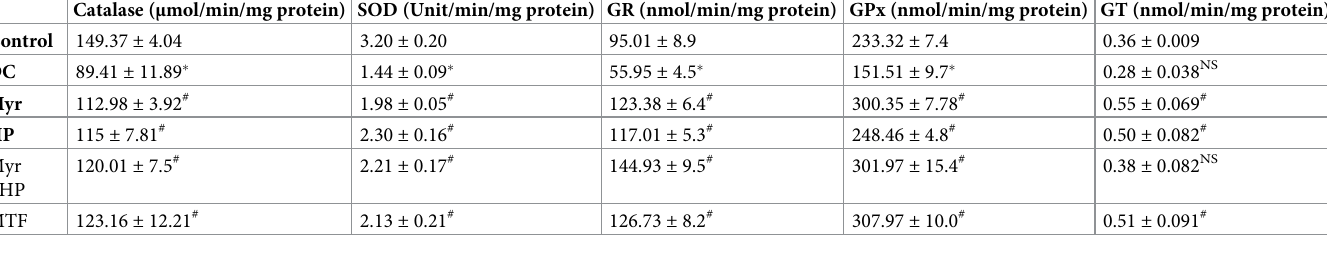
Table 4. Antioxidant enzyme activities in liver.